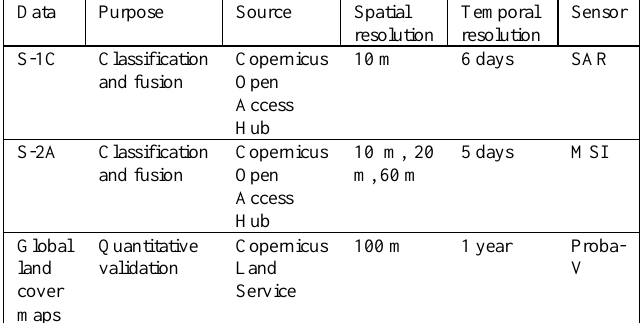
Table 1. Sources and reason of the datasets utilized within the think about with details (Shrestha et al.,